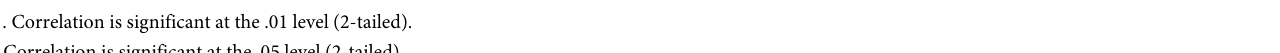
Table 7. Comparisons between groups of prisoners with Pd ( n = 50) and without Pd ( n = 30): U–Mann-Whitney test, SRD effect size. Variables